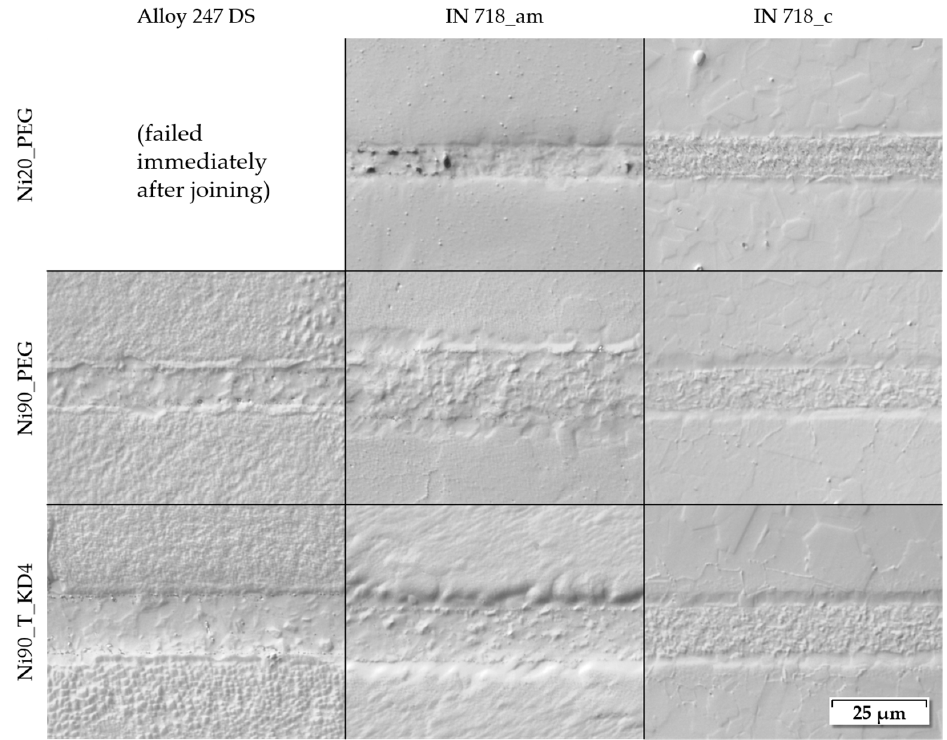
Figure 9. Microstructure of joining seams of all base materials/paste combinations (joining temperature: 870 °C, holding time: 510 s (8.5 min), pressure: 23.3 MPa), light microscope (DICM).